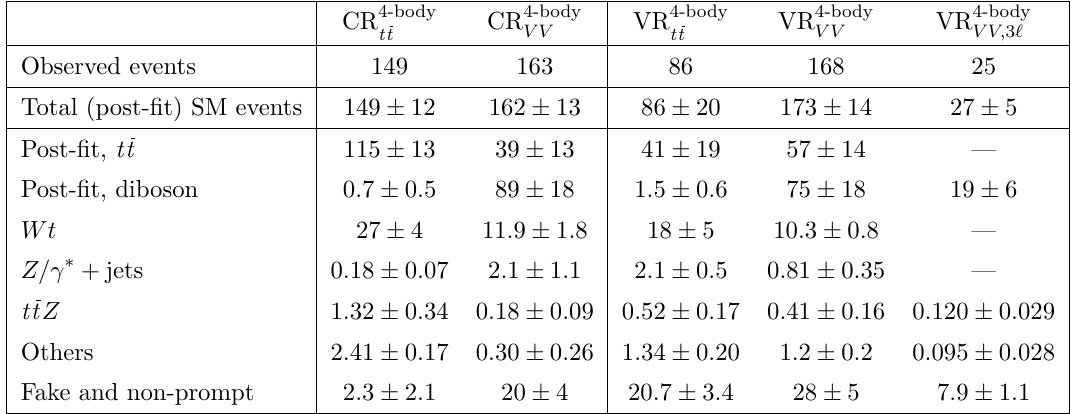
Table 11 . Four-body selection. Background fit results for CR 4-body